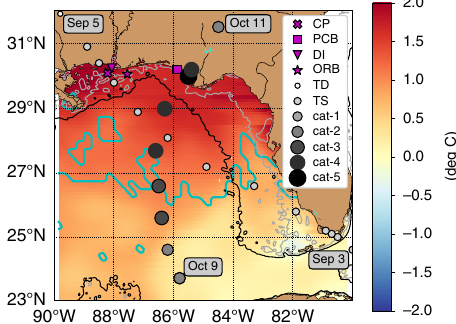
Fig. 1 Map of the study region. Map of the eastern Gulf of Mexico showing 10-day average OISST anomalies relative to a long-term climatological mean (1981 – 2019) between September 27 and October 6 with the region between the cyan contour and land showing the primary area that experienced a marine heatwave within that time period. Closed cyan contours outside or inside this area show pockets with or without marine heatwaves, respectively. Also shown are storm tracks for TS Gordon (lighter gray circles) and Hurricane Michael (darker gray circles) with reference dates and storm categories as well as locations of in situ data stations across the Mississippi Bight: site CP (CP, X ), DPIA (DI, ★ ), Orange Beach Buoy (ORB, ▲ ), and Panama City Beach Fishing Pier (PCB, ■ ). The gray and black contours are the 20 and 100 m isobaths,